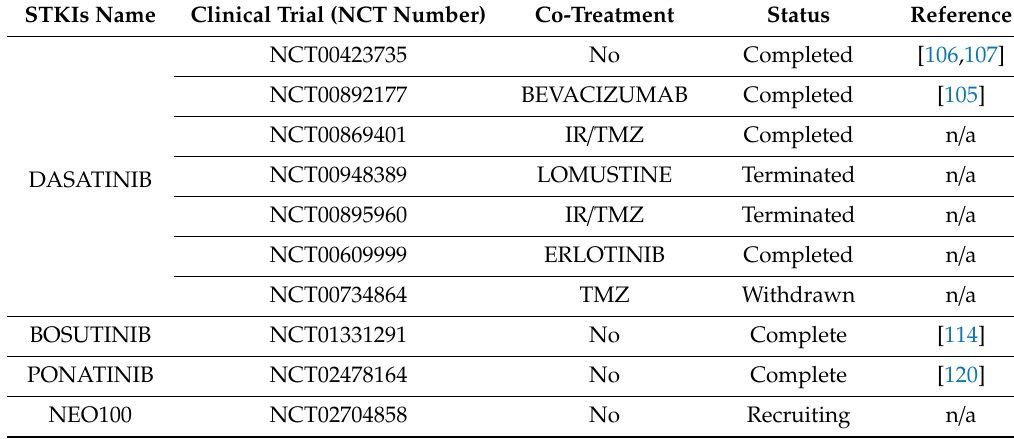
Table 2. Clinical trials for clioblastoma multiforme (GBM) treatment with